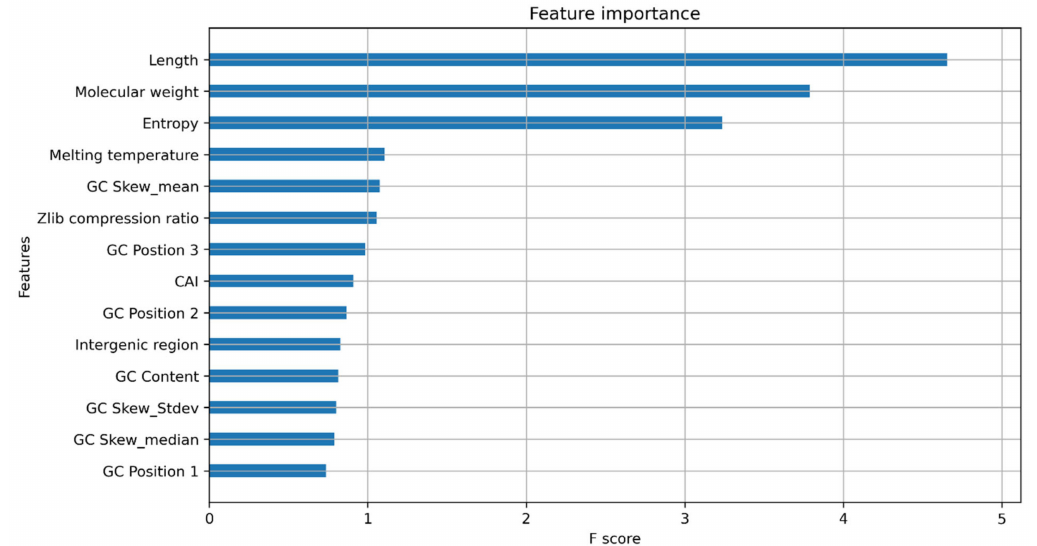
Figure 5. Feature importance gain plot for nucleotide model showing the 14 features contributing the